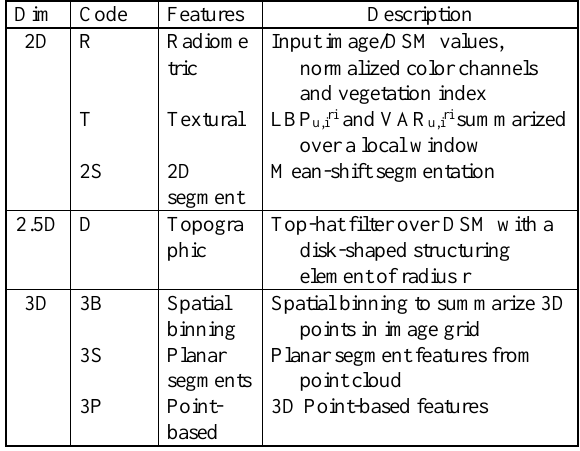
Table 2. List of extracted features used in the classification problem. Dim. = dimension of input data, where 2D indicates the orthomosaic, 2.5D indicates the DSM, and 3D indicates the point cloud. See the text for Where r, g and b are the normalized RGB channels described above.